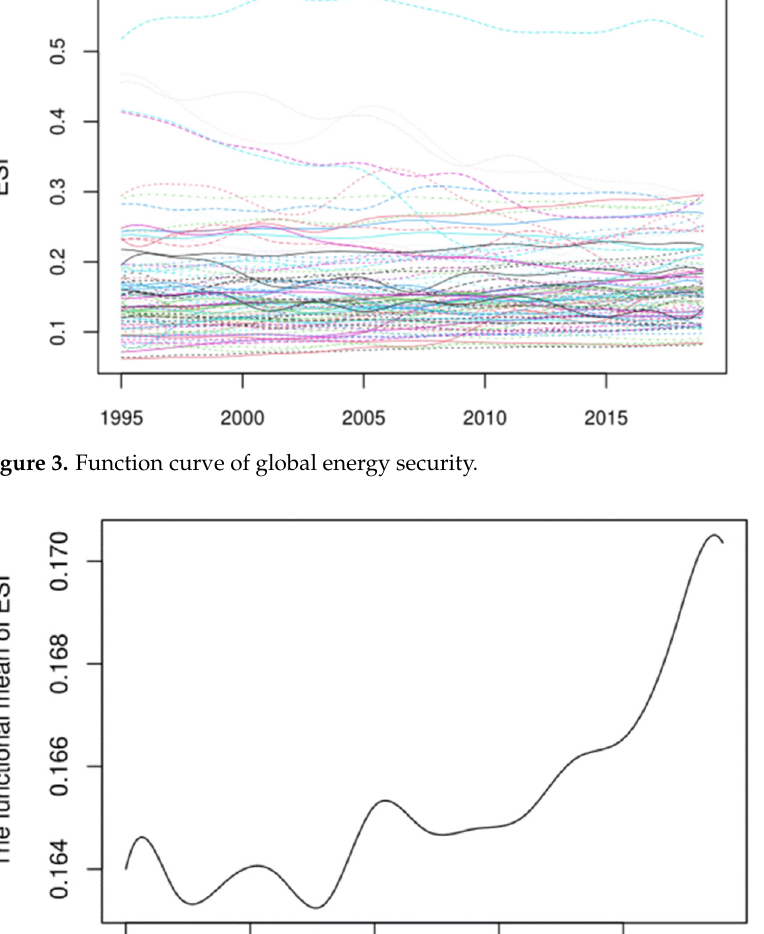
Figure 4. The function curve of energy security means value.